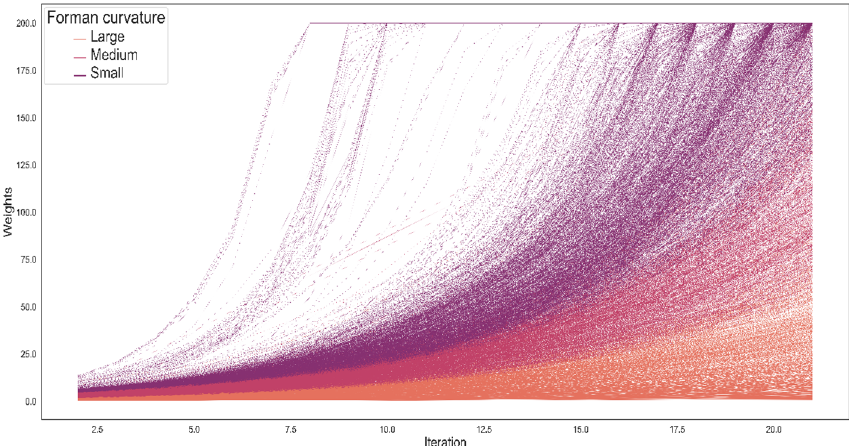
Figure 2. The evolution of edge weights as a function of Forman–Ricci curvature (represented by the different colors) over 20 iterations of Forman–Ricci flow on a semantic network with 183 vertices and 6018 edges. Each line represents the evolution of an edge weight along iterations of Forman–Ricci flow.